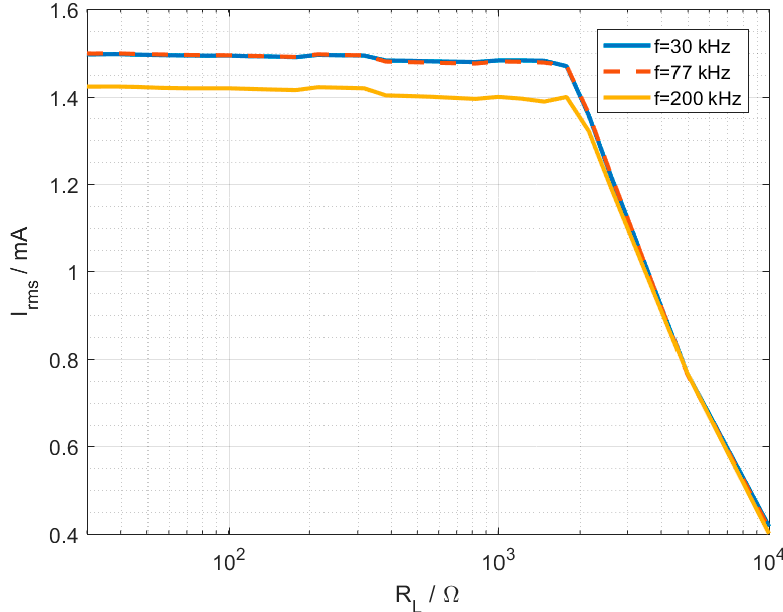
Figure 7. Output current of the current source depending on the load resistance and signal frequency. The output current was 1.5 mA.